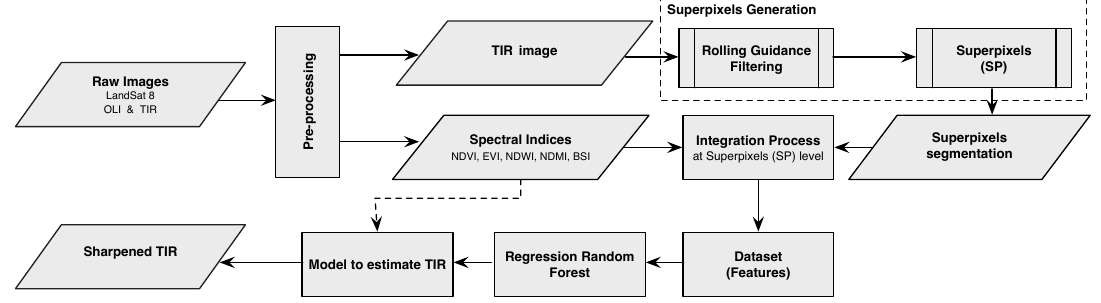
Figure 3. Flowchart of the methodology used to sharpen TIR satellite imagery by TS 2 uRF.